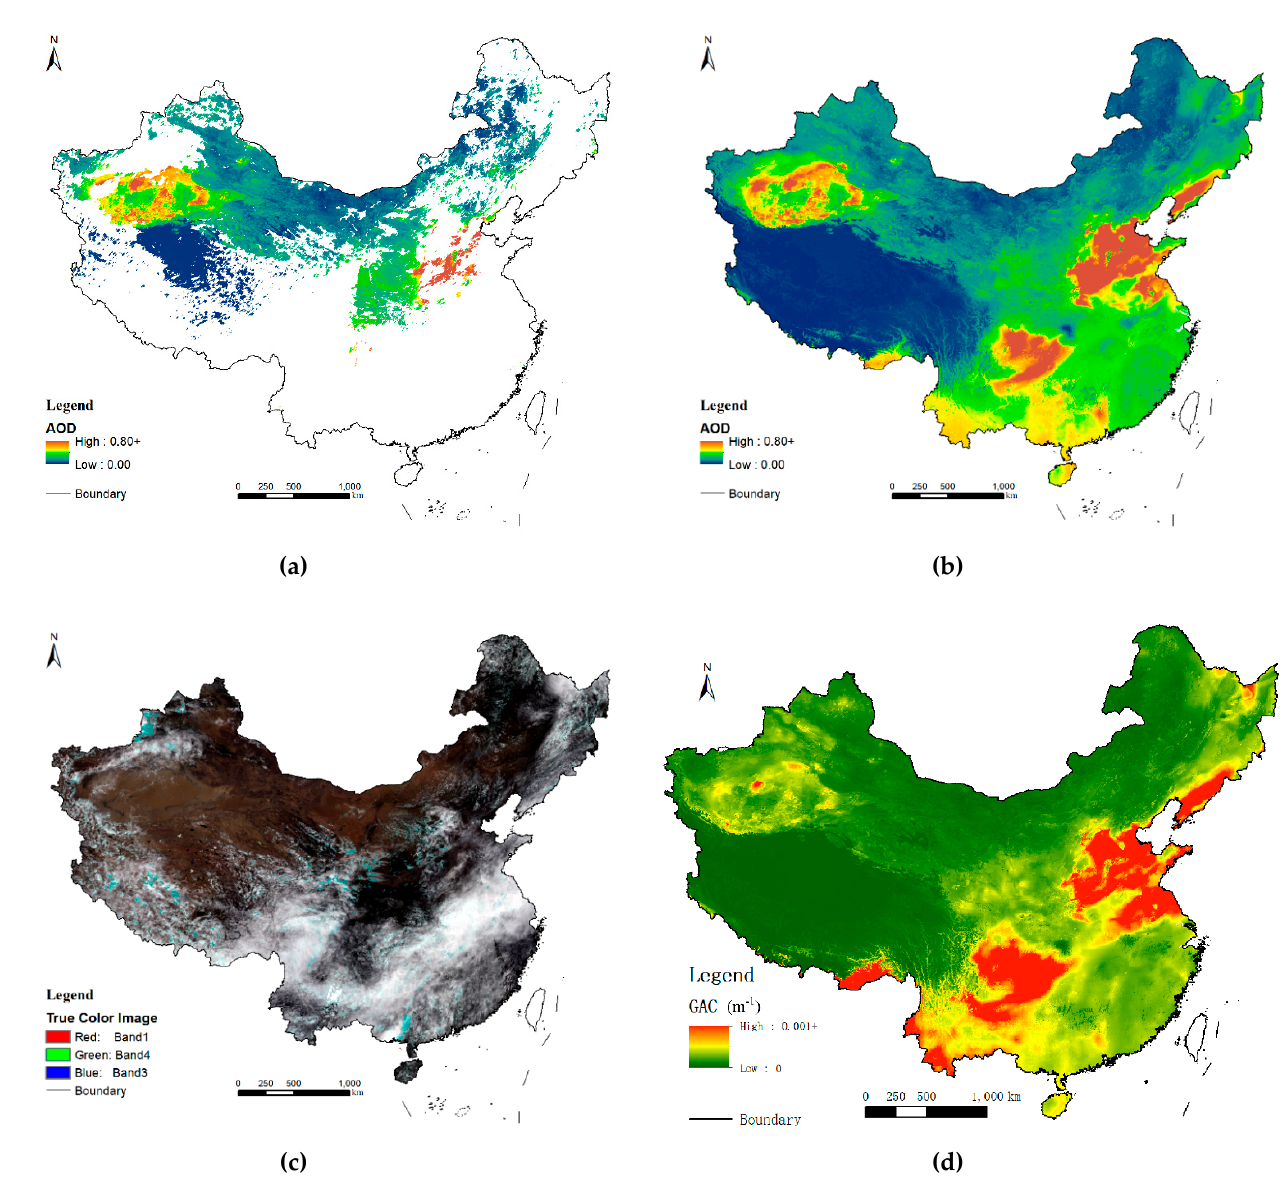
Figure 10. Imputation of MAIAC AOD for a summer day (1 July) of 2016: original AOD ( a ), complete AOD ( b ), MAIAC ground reflectance of true color ( c ) and GAC ( d ).